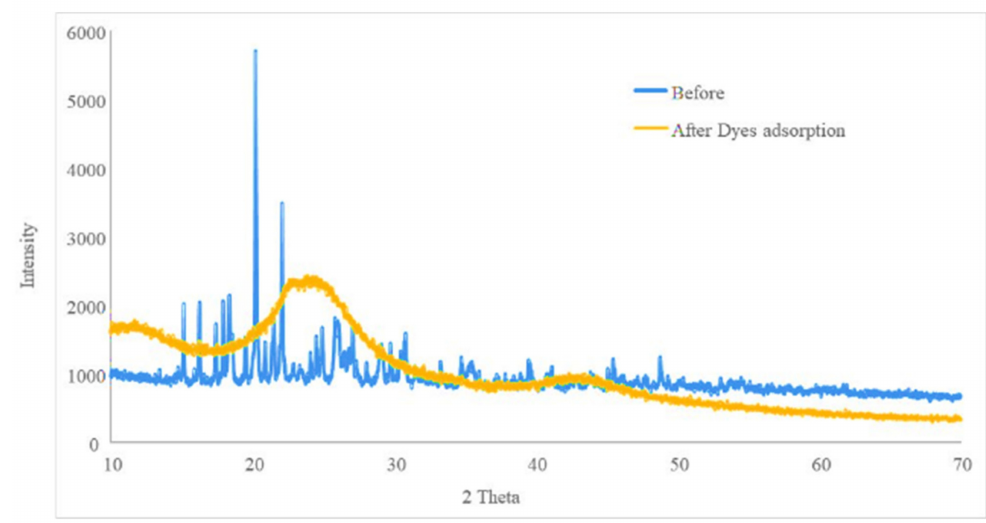
Figure 2. XRD pattern of the solid-phase extraction sorbent before and after the extraction.